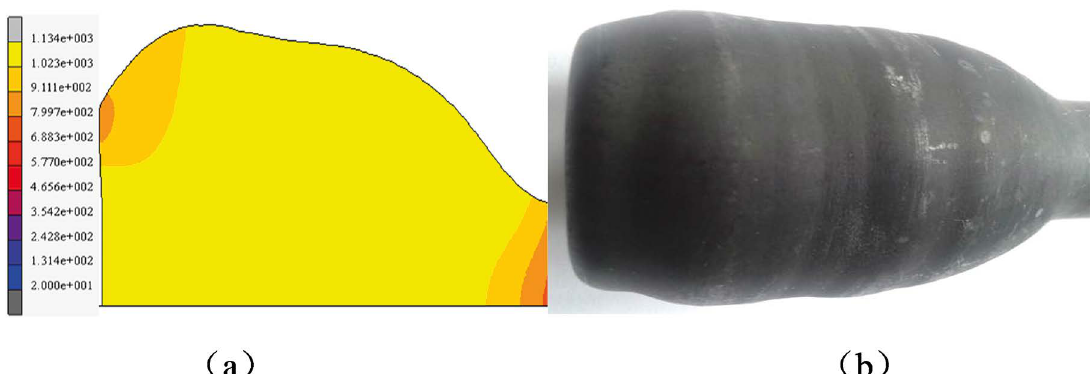
Figure 16: Forming results: (a) in numerical simulation with the developed subroutine, (b) in experiment under the equivalent four-stage current